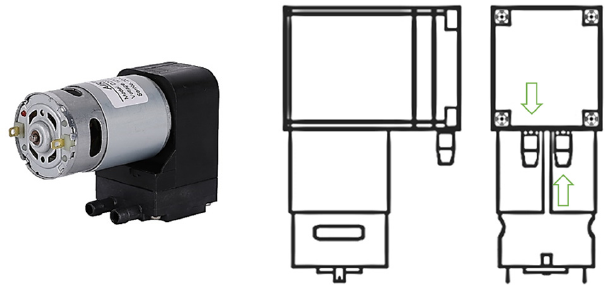
Figure 1. Picture and side shot of a micro electric air